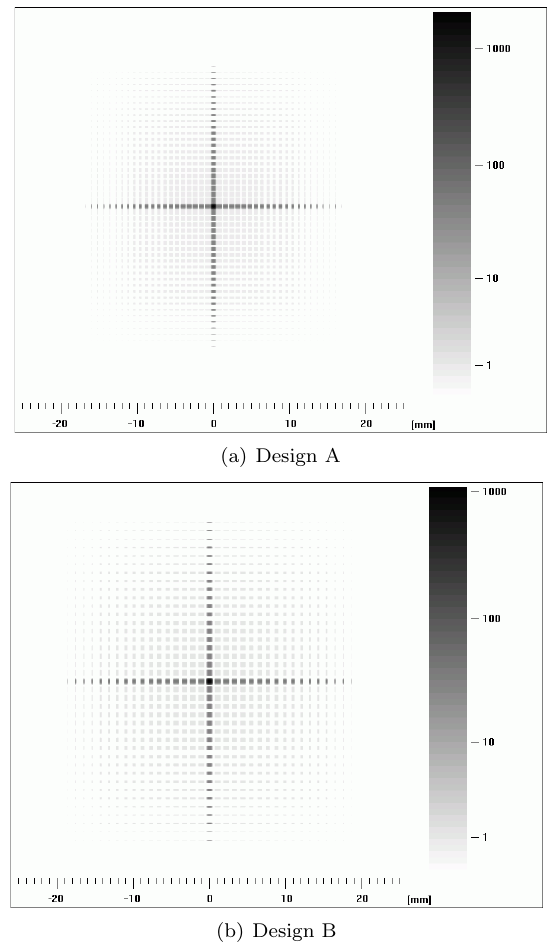
Fig. 2. Basic image at a photon energy of 1